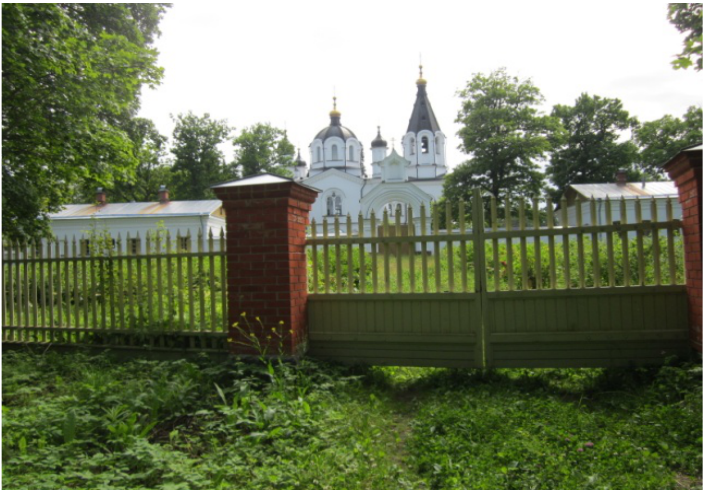
Figure 6 – Valaam monastery. All Saints skete (White). XXI